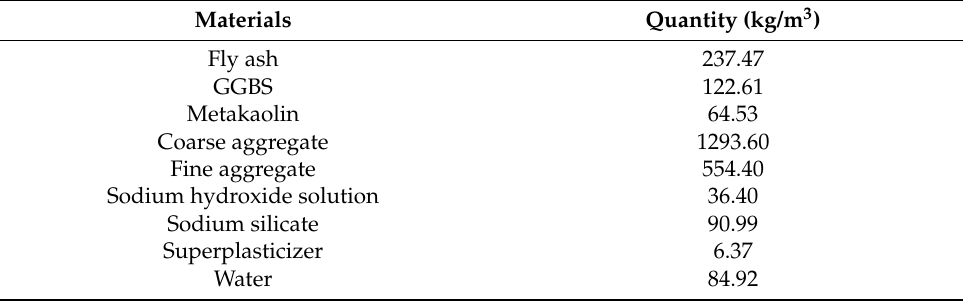
Table 5. Mix proportions of Ternary blend geopolymer